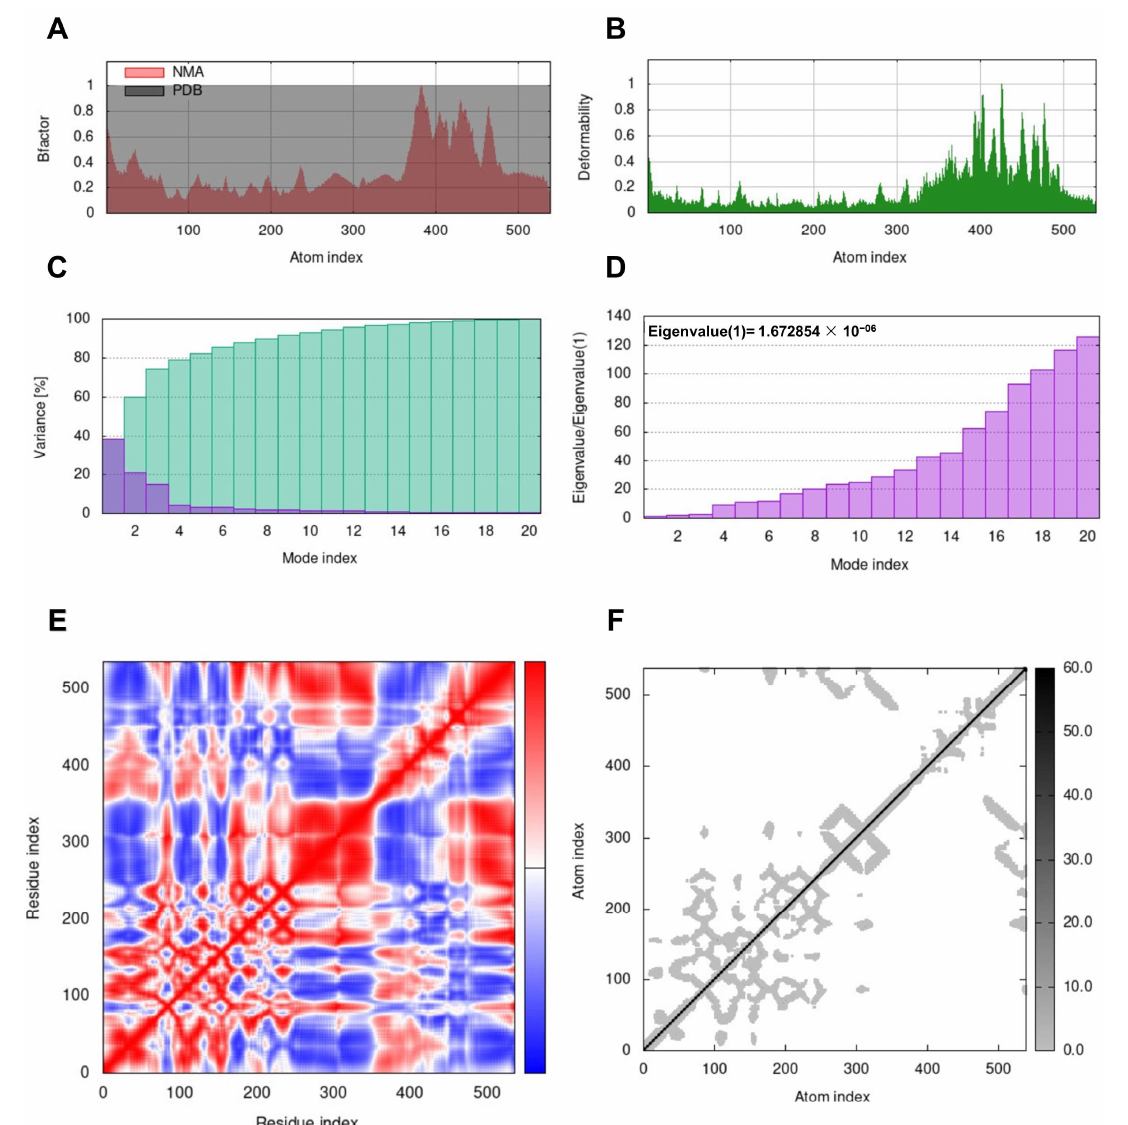
Figure 4. The iMOD server’s normal mode analysis (NMA) outputted the following plots. ( A ) B-factor, ( B ) deformation plot, ( C ) variance plot, ( D ) eigenvalues, ( E ) covariance matrix plot (The anticorrelated, uncorrelated, and correlated states of atomic motion are represented by the blue, white, and red, hues respectively), and ( F ) elastic network model where grey color represents atom connections).